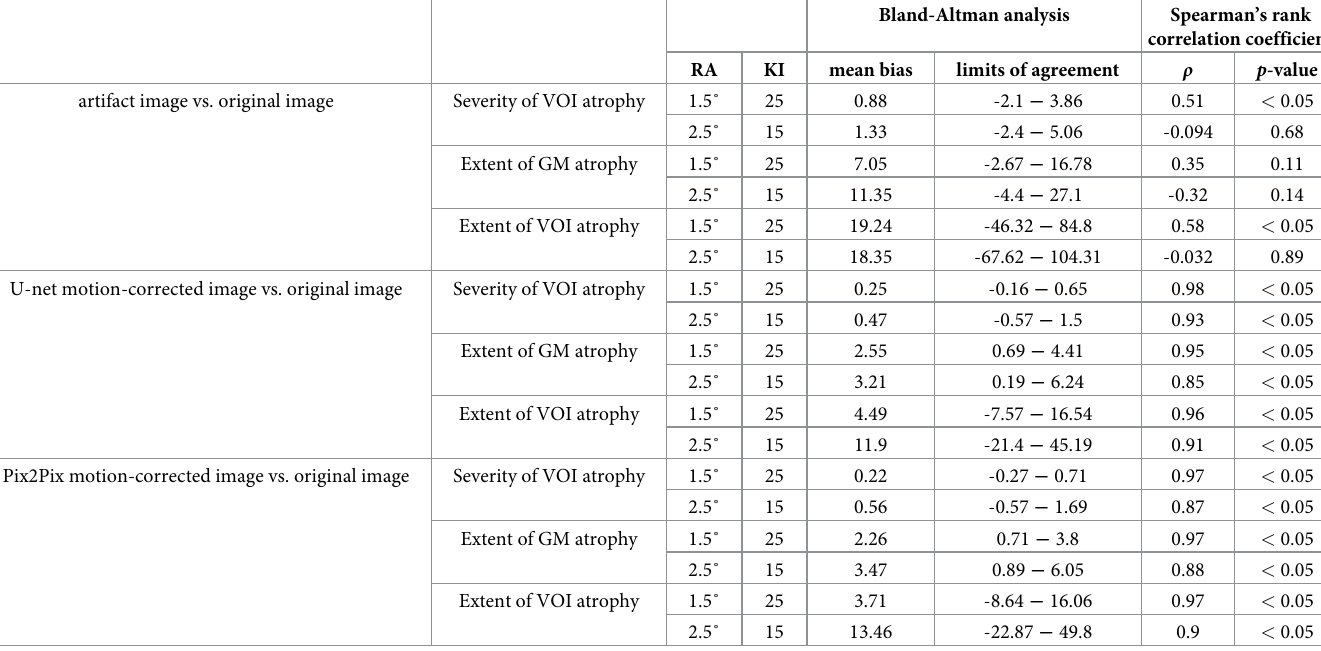
Table 4. Results of Spearman’s rank correlation coefficient analysis and Bland-Altman analysis when set to non-trained rotation angles and k-space intervals.